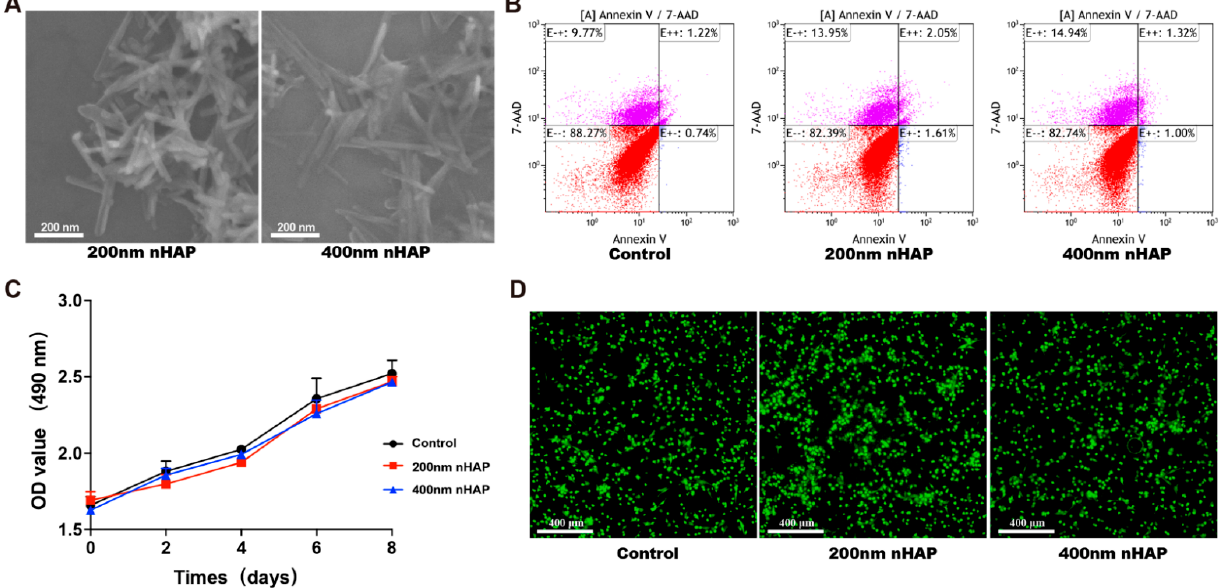
Figure 1. Characterization and biocompatibility of the nHAPs. ( A ) The SEM images of nHAP. ( B ) Percentages of apoptotic macrophages cultured with nHAP using Annexin V-7-AAD staining determined by flow cytometry. ( C ) Cell viability of macrophages cultured for 2, 4, 6, and 8 days with nHAP by MTT assay. ( D ) Live and Dead staining of Macrophages.